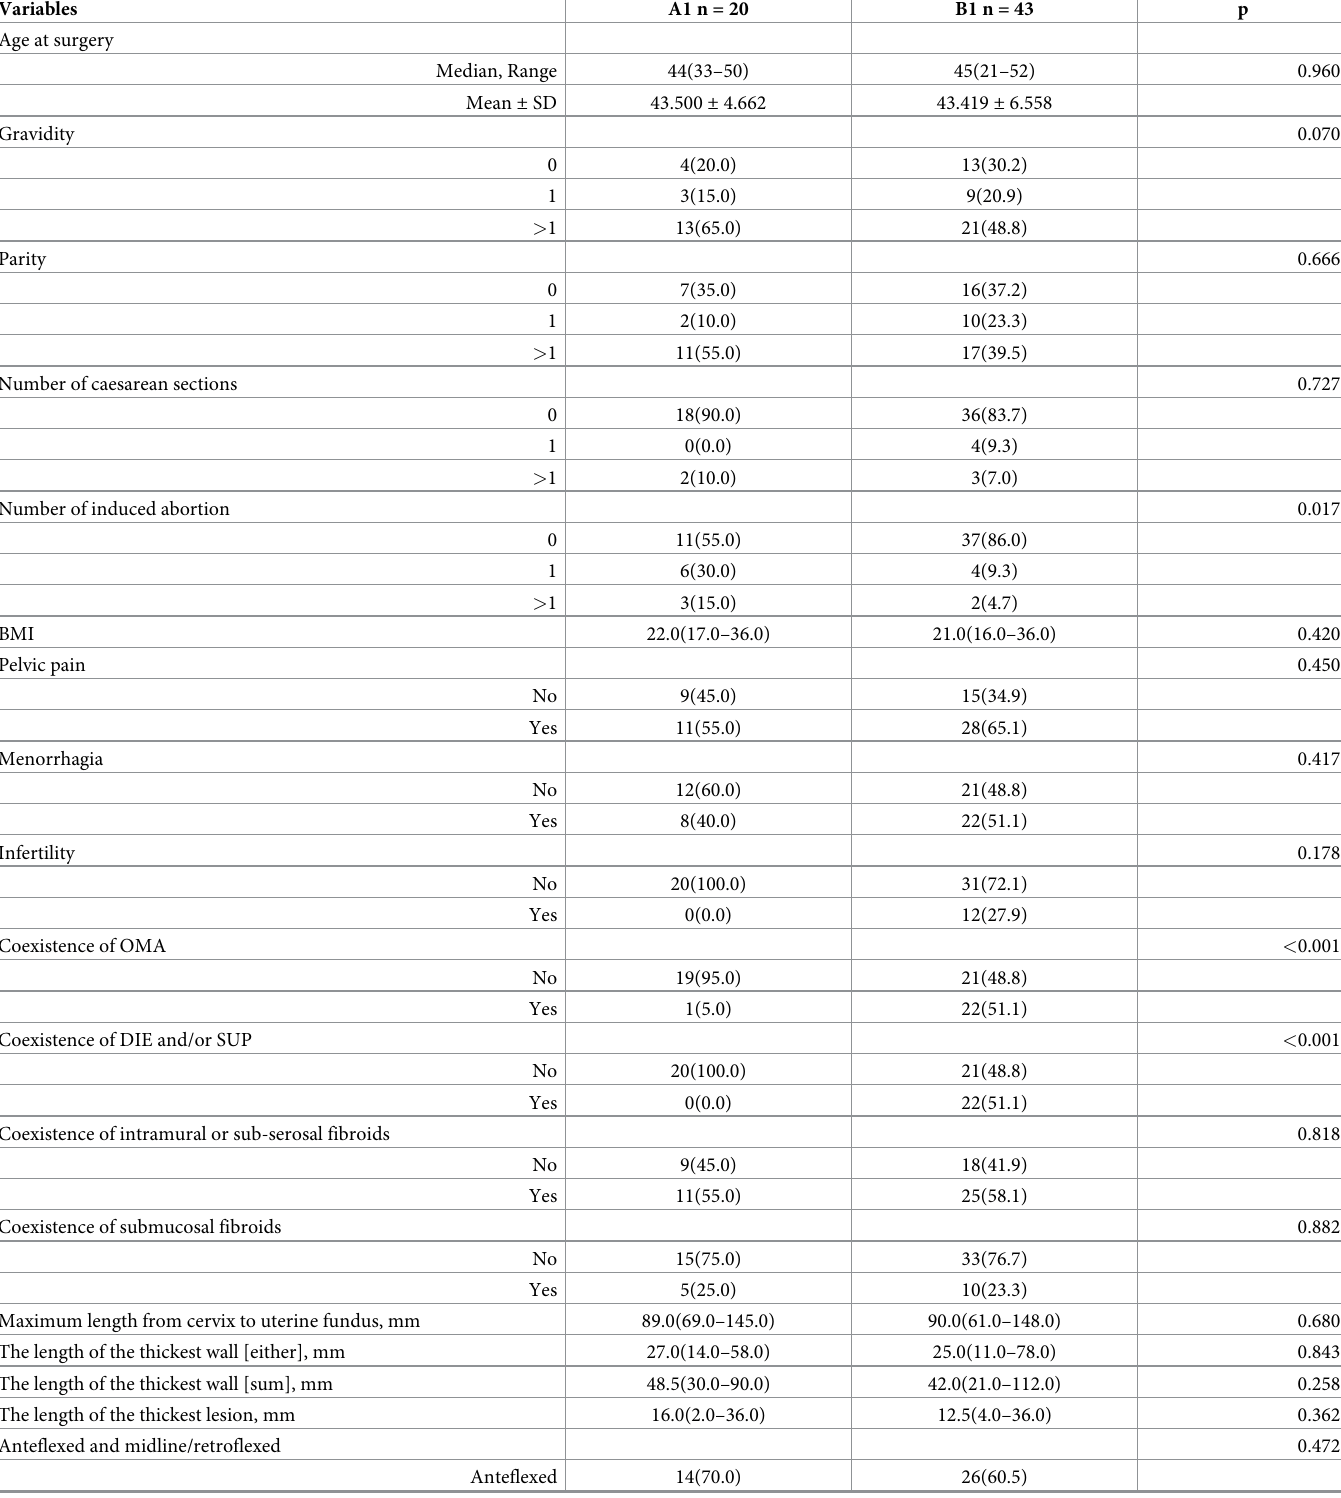
Table 2. Clinicopathological variables in patients with A1 and B1